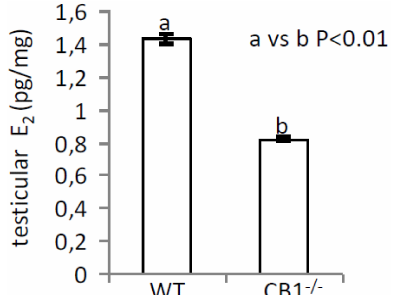
Figure 4. E 2 levels in testis from WT and CB1 - / - mice by EIA assay. Values were expressed in pg for mg of tissue (pg / mg) and reported as mean values ± S.E.M. Graph was representative of three testis from six di ff erent animals / genotype ( n = 6 animals for each genotype in triplicates) (a vs. b p < 0.01). / - Gene expression analysis of Cdyl and Brdt showed no significant di ff erences, WT vs. CB1 - (Figure 5A), while significant variation was observed when we analyzed histone H3 and H4tetraAc levels. Quantitative densitometry analysis of signals showed a significantly higher histone H3 content / - in CB1 - than in WT mice both in testis ( p < 0.01) and in caput SPZ ( p < 0.05). Relatively to total histone / - content, histone H4tetraAc was higher in WT compared to CB1 - testis (Figure 5B,C).